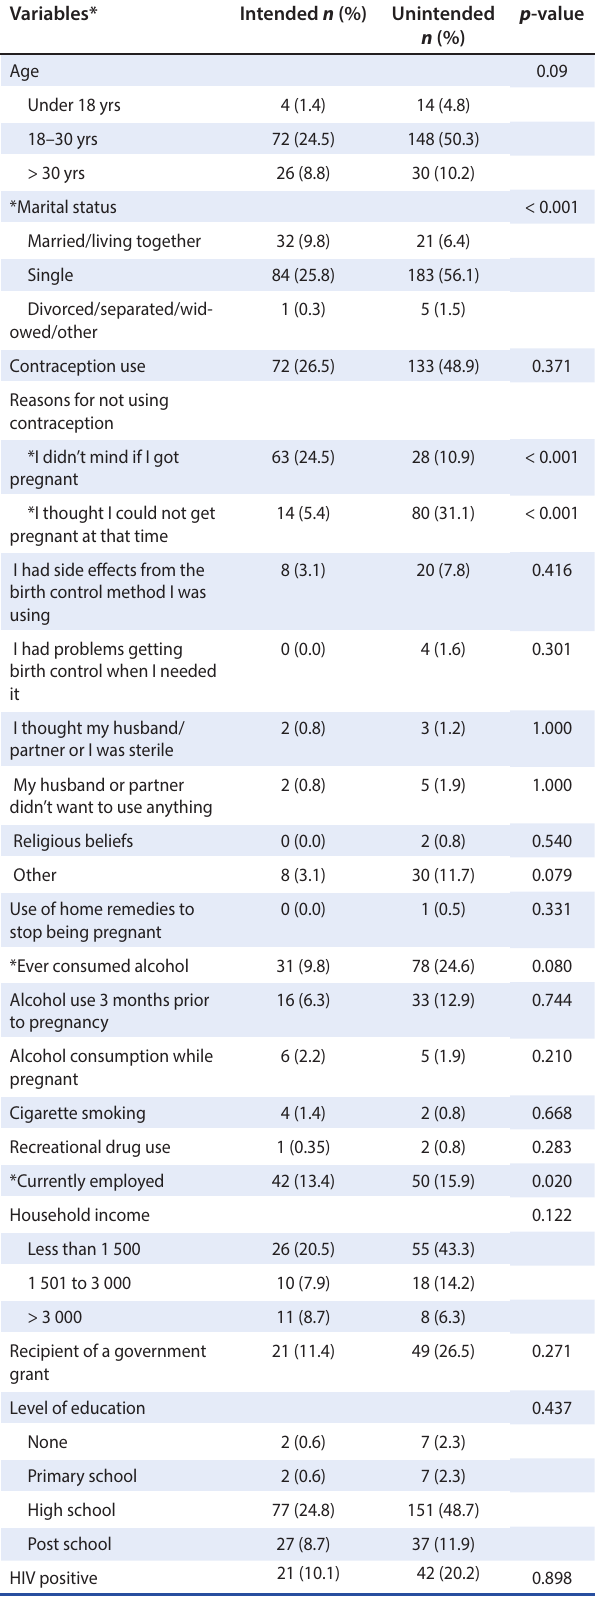
Table 3: Multivariate logistic regression of unintended pregnancy by marital status, alcohol used during pregnancy and beneficiary of